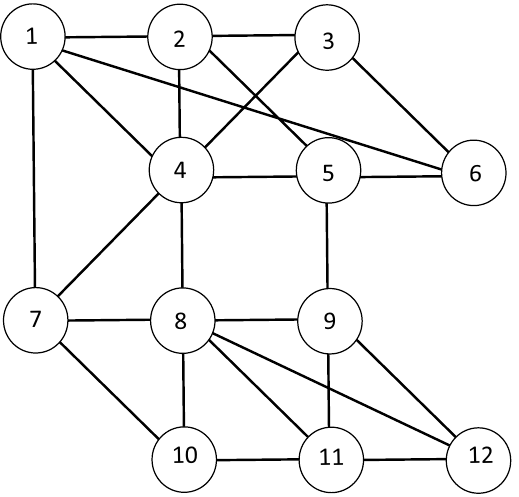
Figure 1. Toy example of the framework. The minimum PDC {{1, 2, 3, 4, 5, 6}, {7, 8, 9, 10, 11, 12}} is in Nash equilibrium as no player can gain from unilateral deviation.